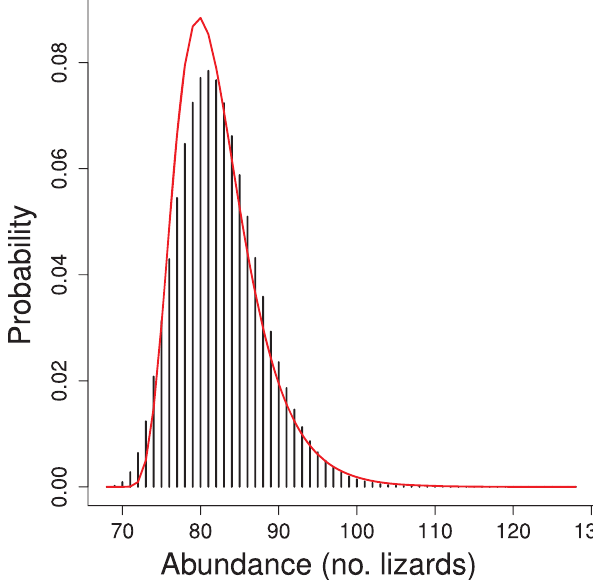
Figure 6. Posterior distribution of abundance of lizards in the 9 ha search area. Red line indicates the estimated sampling distribution of empirical Bayes estimates of abundance. doi:10.1371/journal.pone.0084017.g006 PLOS ONE |